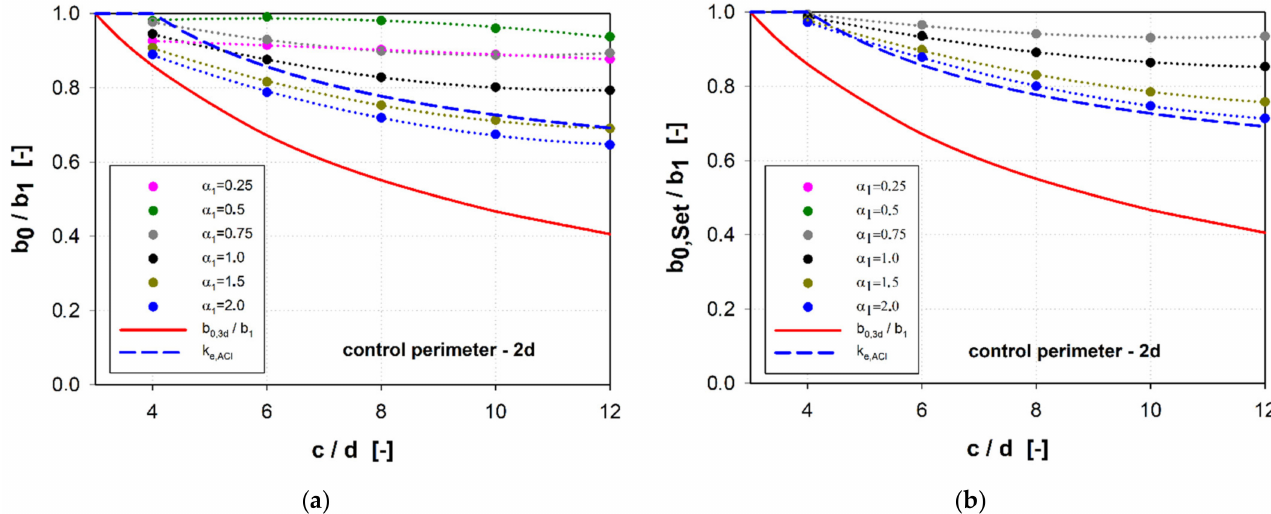
Figure 13. Comparison of methods for calculating the effective length of a control perimeter 2 d : ( a ) reduction of the control perimeter according to the general method of MC2010 ( b 0 / b 1 ); ( b ) reduction of the control perimeter according to [36] b 0, Set / b 1